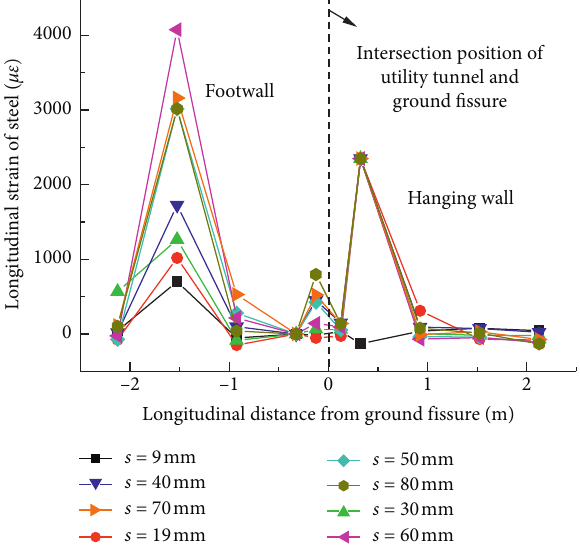
Figure 15: Longitudinal strain of top reinforcement. Figure 17: Longitudinal strain of bottom